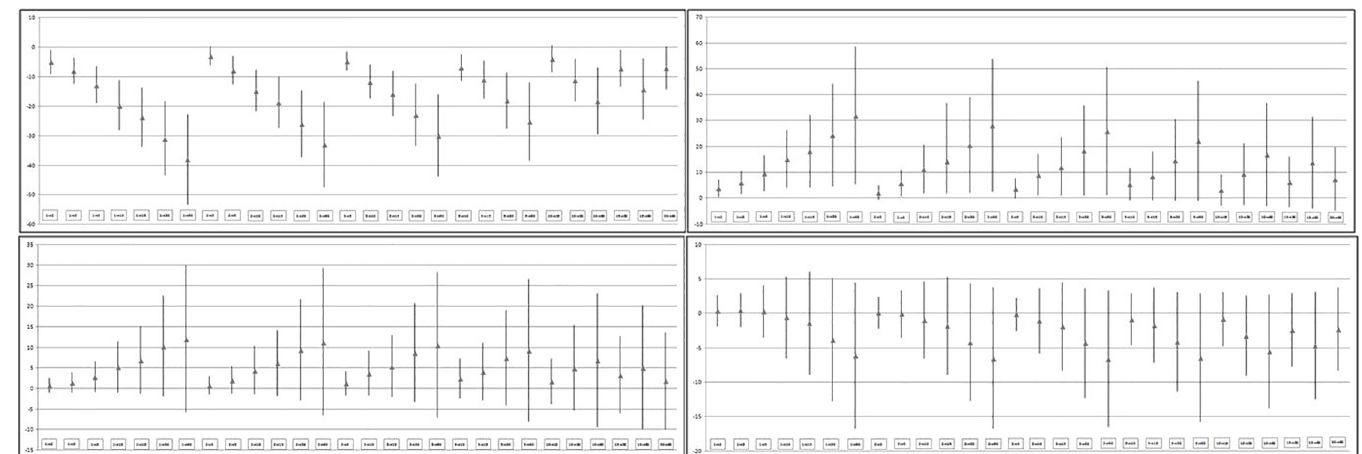
Fig 2. Bias and 95% confidence intervals for each epoch for Sedentary, Light, Moderate and Vigorous Activity.